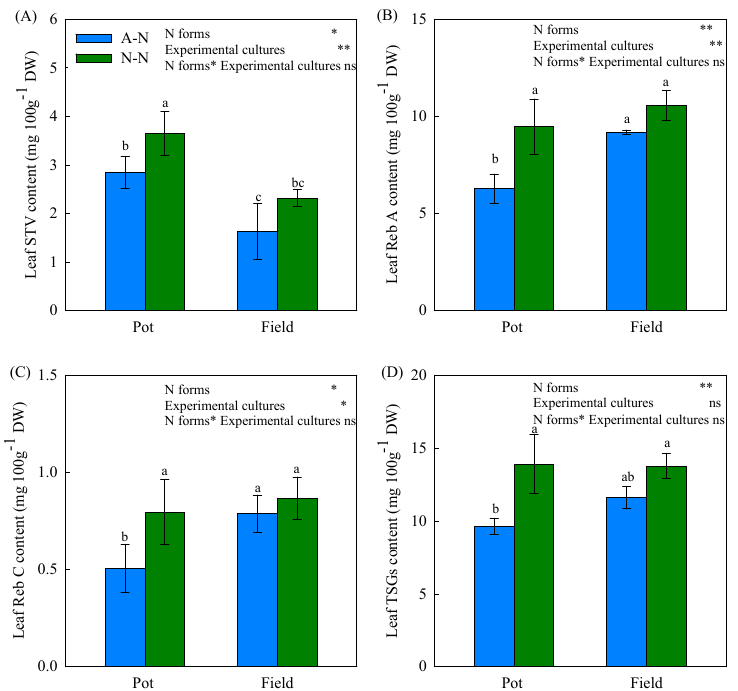
Figure 1. Effect of nitrogen forms on the leaf contents of stevioside (STV, A ), rebaudioside A (Reb A, B ), rebaudioside C (Reb C, C ) and total steviol glycosides (TSGs, D ) of stevia plant growing in pot and field conditions (“experimental cultures”). Stevia plants growth under pot or field conditions were fed with ammonium–nitrogen (A-N) or nitrate–nitrogen (N-N) to the same N level. Values represent the means ± SD of three biological replicates. ANOVA results are indicated; different letters indicate significant differences in the same indicator, *, ** and ns indicate significant difference at 0.05, 0.01 probability levels and nonsignificant difference,